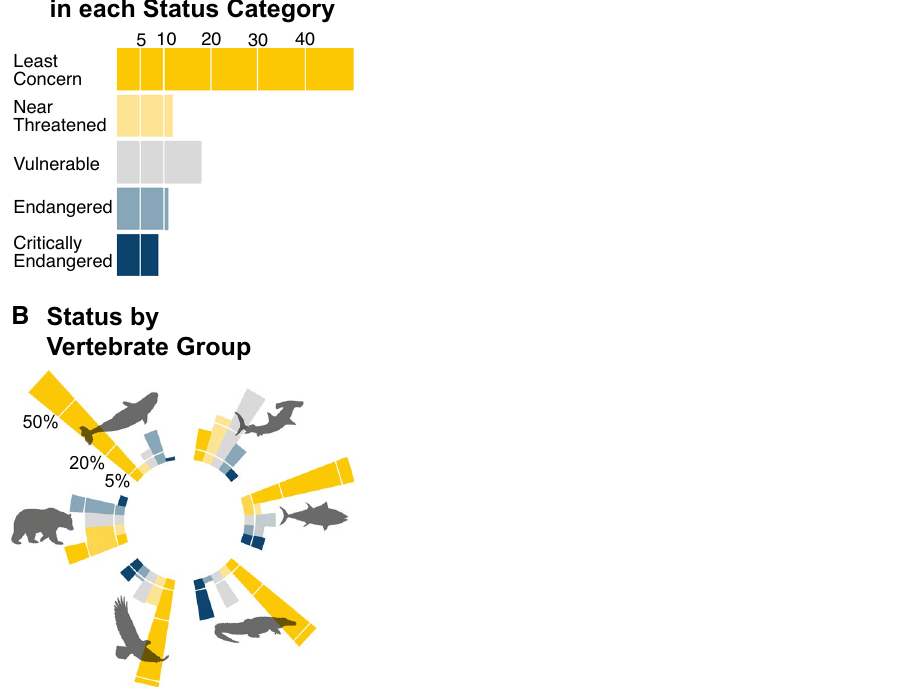
Figure 2. Current IUCN extinction risk. ( A ) Percent of large carnivore species that occupy each extinction risk category. Percentages calculated from species with known status only (i.e., ‘Data Deficient’ species omitted). Least Concern (LC) = 50.6%, Near Threatened (NT) = 11.6%, Vulnerable (VU) = 17.1%, Endangered (EN) = 11.0%, Critically Endangered (CR) = 9.7%. ( B ) Percent of species in each extinction risk